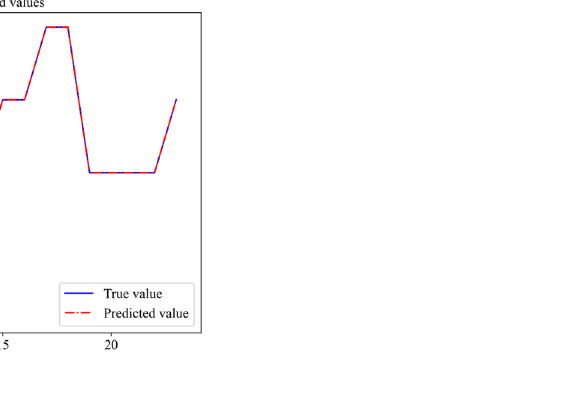
Figure 14. Prediction performance of random forests